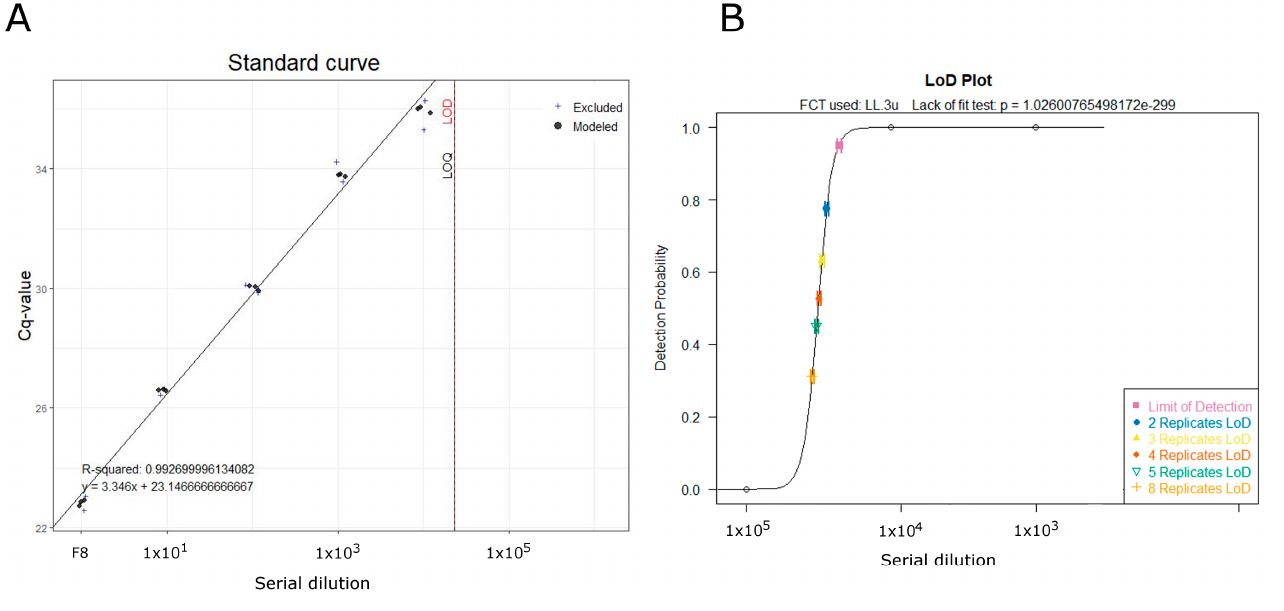
Figure 2. Output from Klymus script with minor modification. ( A ) Calibration curve plot with quantitative cycles (Cq) value on the y-axis and serial dilution of F8 sample (from as it is F8 up to a dilution of 1 × 10 − 5 ) on the x-axis. Points drawn with black circles are the middle 2 quartiles of standards with ≥ 50% detection and are included in the linear regression calculations. Points drawn with blue pluses (+) are outside the middle 2 quartiles or for standards with <50% detection and are not included in the linear regression. R-squared = coefficient of determination and y-int = y intercept. Additional dilutions of 10 5 and 10 6 are not visible in the plot since they were not amplified. ( B ) Limit of detection (LOD) plots. Detection probability is on the y-axis and serial dilutions of the F8 sample (from as it is F8 up to a dilution of 1 × 10 − 5 ) are on the x-axis. Points are drawn with open circles for the detection rates of each standard tested, and the line represents the LOD model. Colored points with 95% confidence intervals are drawn to represent the LOD and effective LODs for multiple replicate analyses. The logarithmic function used and the lack of fit test results are shown in the